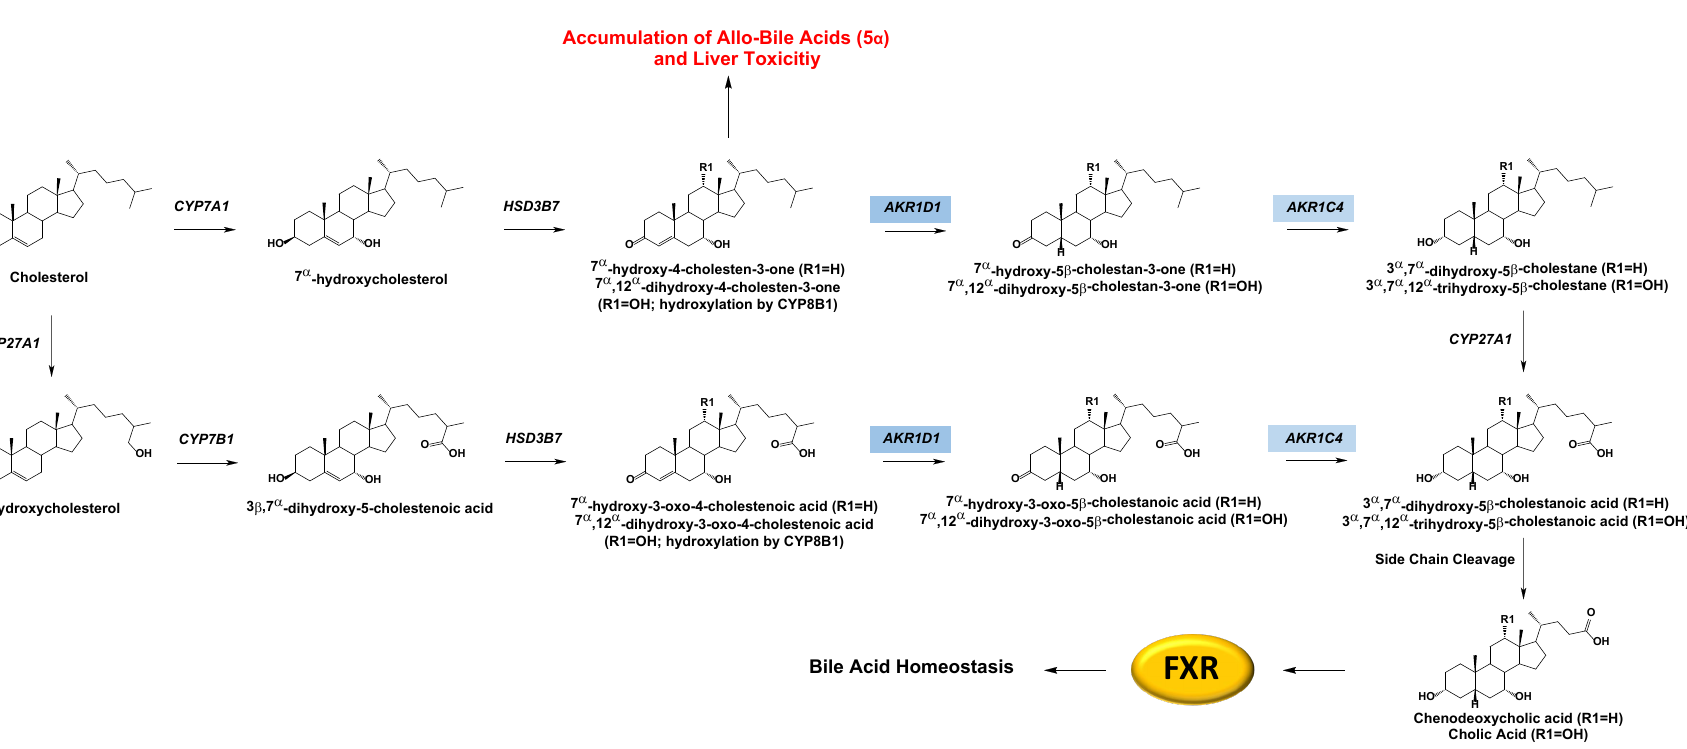
Figure 4. Role of AKR1C4 and AKR1D1 in Classical (neutral) and Alternative (acidic) Bile Acid Metabolism to regulate farnesoid X receptor (FXR). The FXR is required to regulate bile acid homeostasis. 5 β -reductase deficiency, such as mutation of AKR1D1, shunts the pathway away from proper bile acid metabolism and leads to the accumulation of allo-bile acids resulting in liver toxicity.